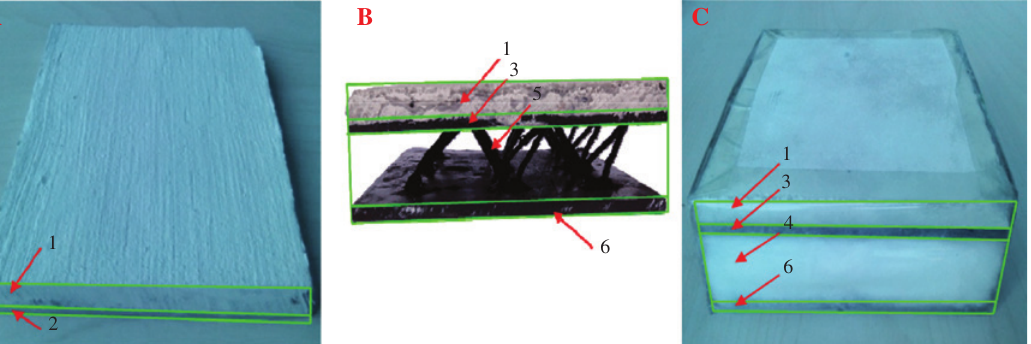
Figure 5: Photographs of test samples: (A) aluminum alloy panel covered with intumescent coating; (B) lattice reinforced sandwich structure without foam core; (C) complete fire-proofing composite lattice sandwich structure. Sample (A) is tested to validate the thermal-proofing property of coating; sample (B) for the lattice reinforced sandwich structure and the coating but without foam core; while sample (C) for the whole structure, where 1 refers to virgin intumescent coating, 2 refers to substrate (aluminum alloy), 3 refers to the facesheet exposed to